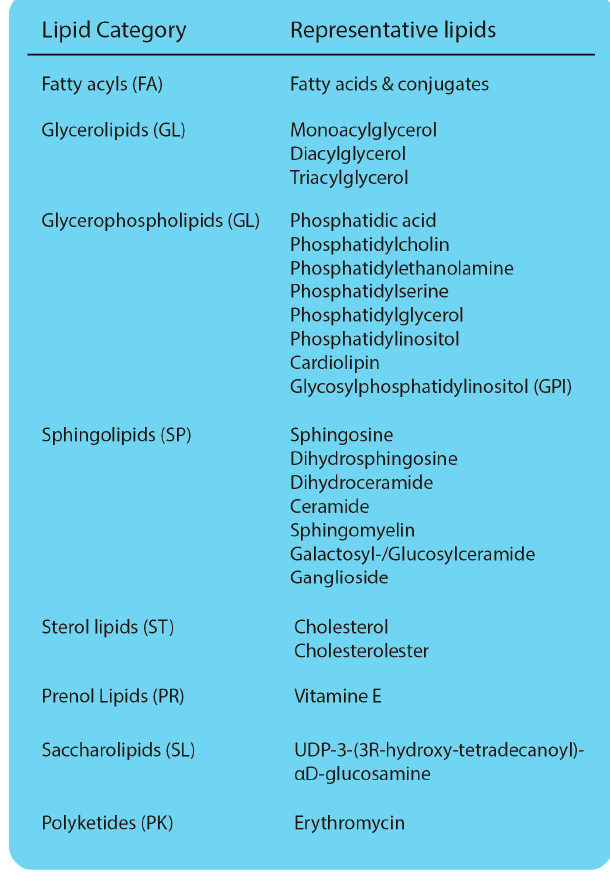
Figure 1. Lipid classes and representative lipids. Classification according to LIPID MAPS ®